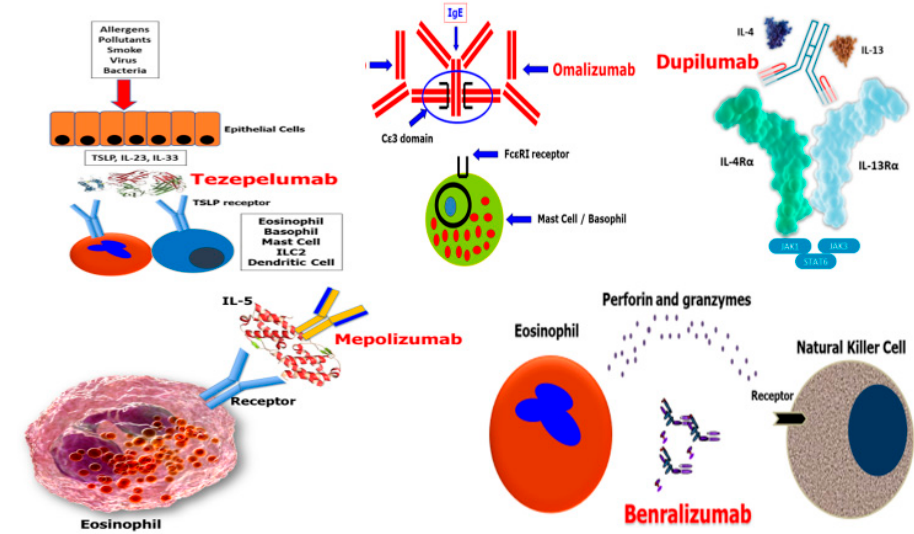
Figure 1. At-a-glance molecular mechanism of action of biologics.